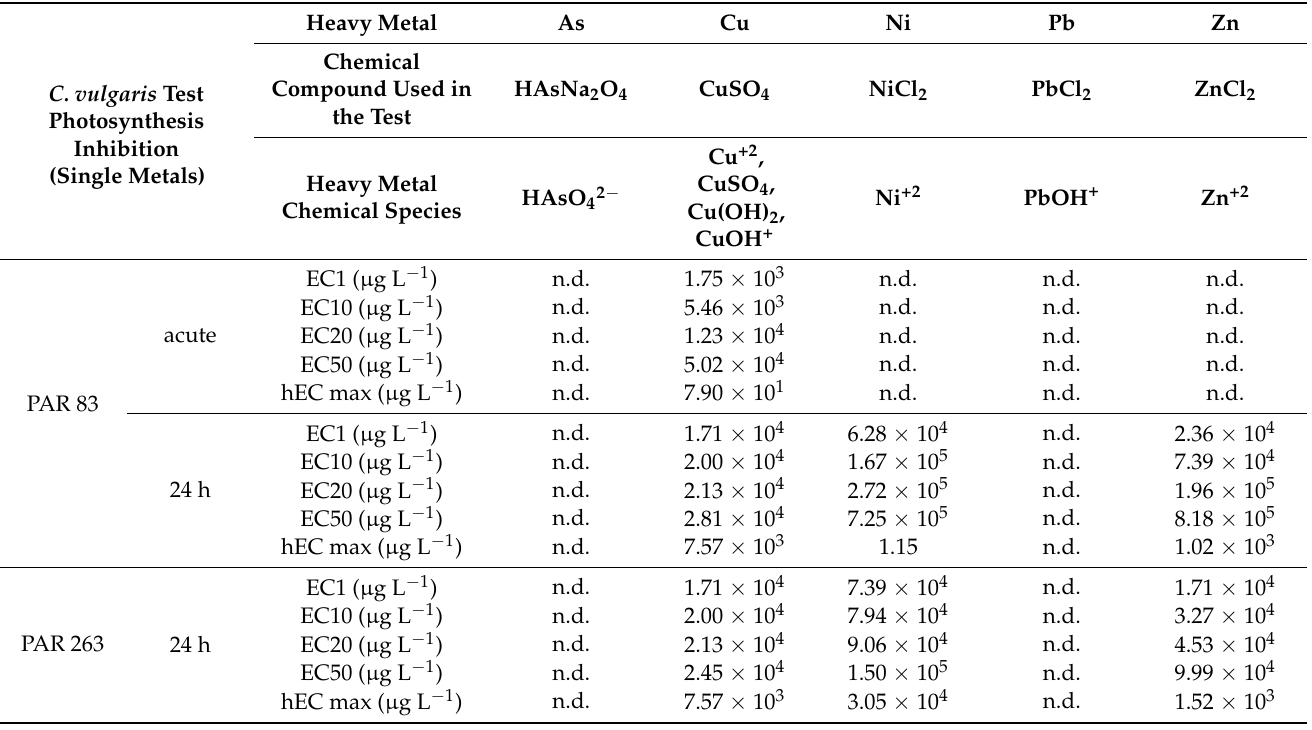
Table 6. Maximum stimulation concentration (hEC) and selected effective concentrations (ECx, ppb) of YII for Cu, Ni, and Zn, calculated with Matlab concentration-response curves for single metal